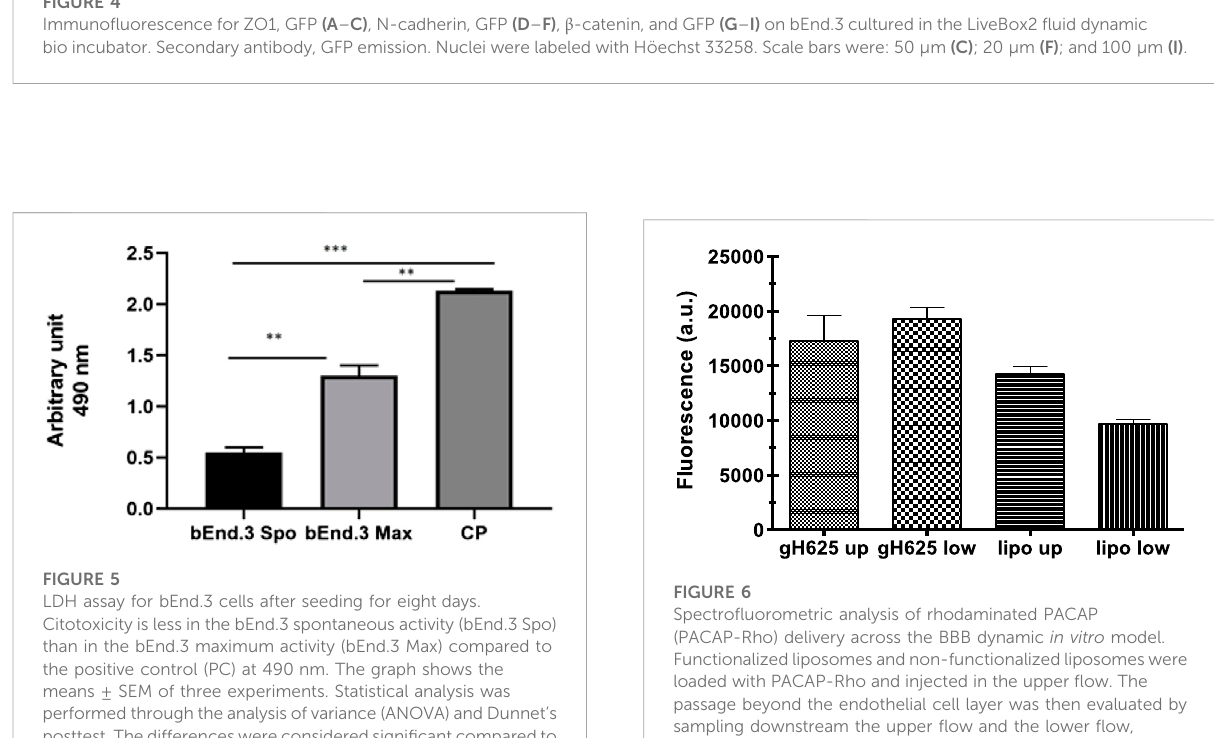
FIGURE 5 LDH assay for bEnd.3 cells after seeding for eight days. Citotoxicity is less in the bEnd.3 spontaneous activity (bEnd.3 Spo) than in the bEnd.3 maximum activity (bEnd.3 Max) compared to the positive control (PC) at 490 nm. The graph shows the means ± SEM of three experiments. Statistical analysis was performed through the analysis of variance (ANOVA) and Dunnet ’ s posttest.Thedifferenceswereconsideredsigni fi cantcomparedto positive c(PC). *** p < 0.0001; ** p < 0005.